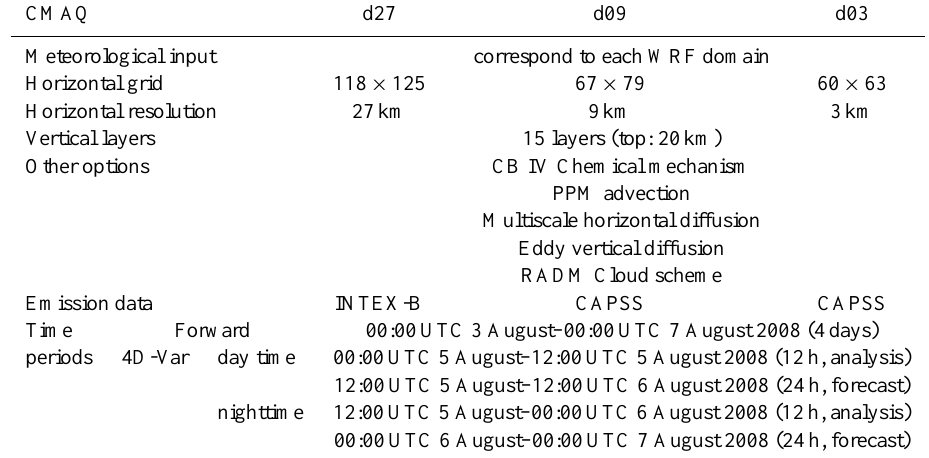
Table 2. Configuration of CMAQ 4D-Var modeling system.